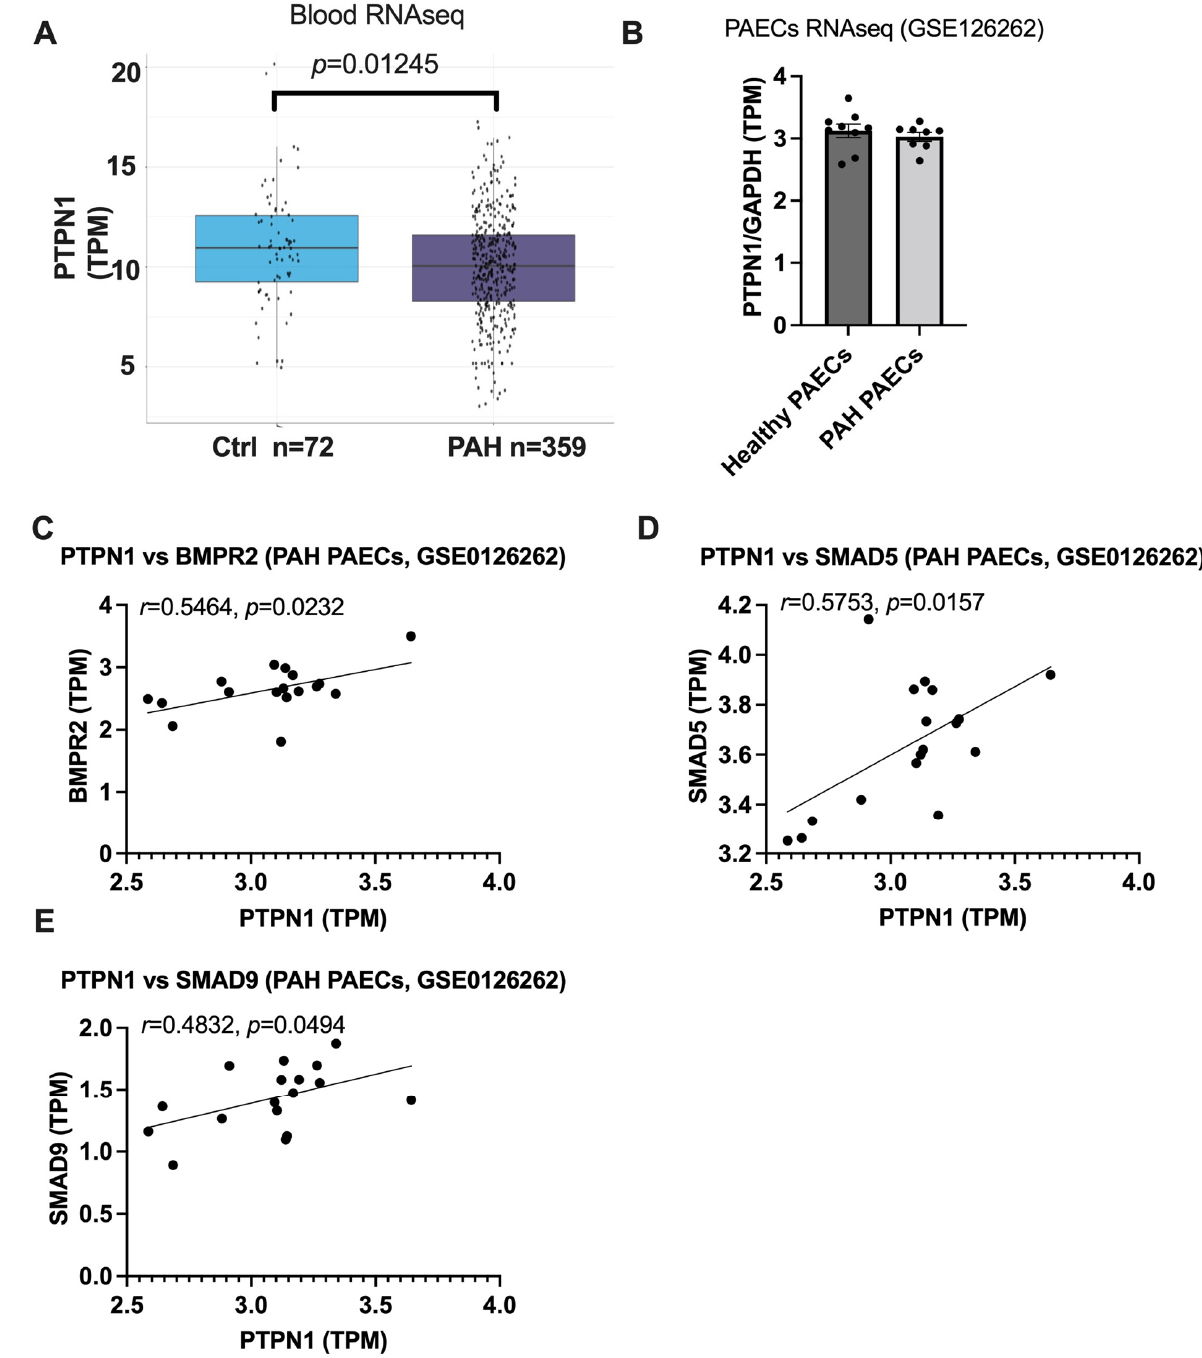
Figure 4. PTPN1 is downregulated in the blood but not in the PAECs of PAH patients. We ana- lyzed RNA-seq data of PTPN1 expression in the whole blood ((n = 72 healthy and n = 359 PAH), for subject characteristics, please see [22]) ( A ) and in PAECs (n = 9/group, (GSE0126262, [23])) of PAH patients ( B ). TPM values for PTPN1 expression is shown in the graphs. PTPN1 was correlated with expression of BMPR2, SMAD5, and SMAD9 in healthy and PAH PAECs (GSE0126262) ( C –E).